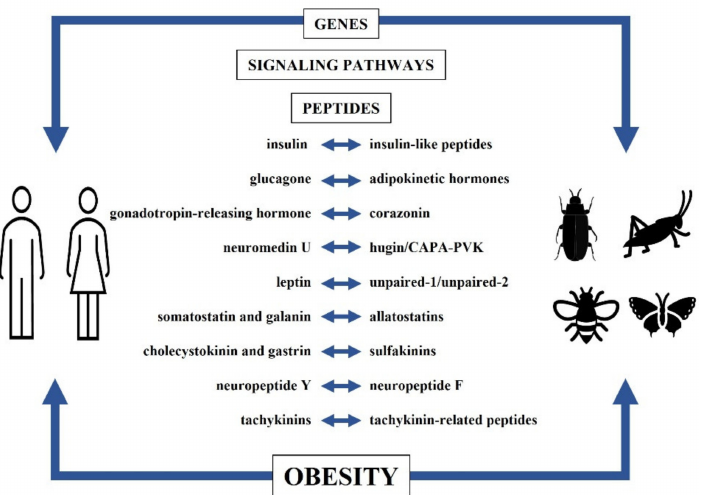
Figure 1. Similarities between human and insects’ factors correlated with obesity